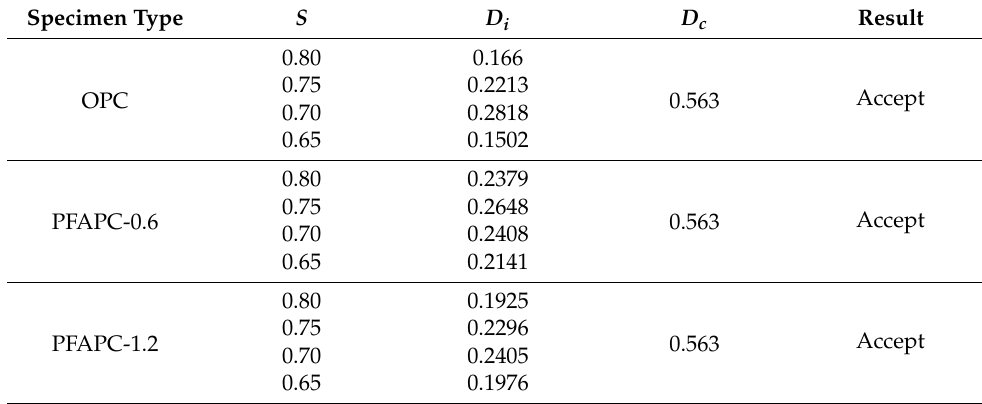
Table 7. KS test